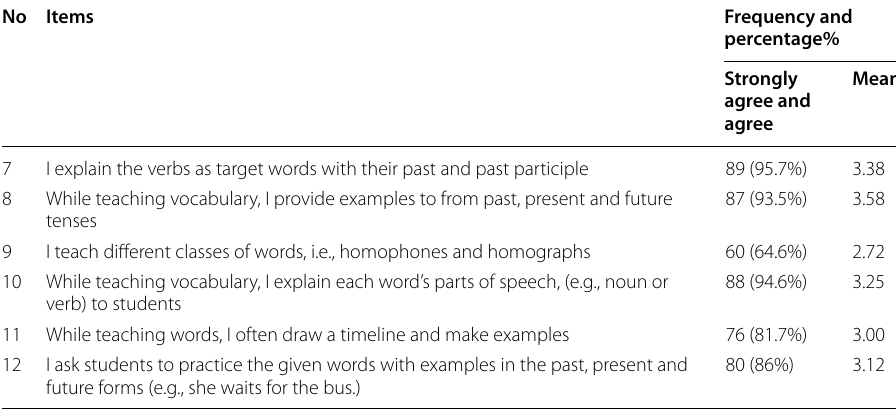
Table 3 Teaching vocabulary through lexical